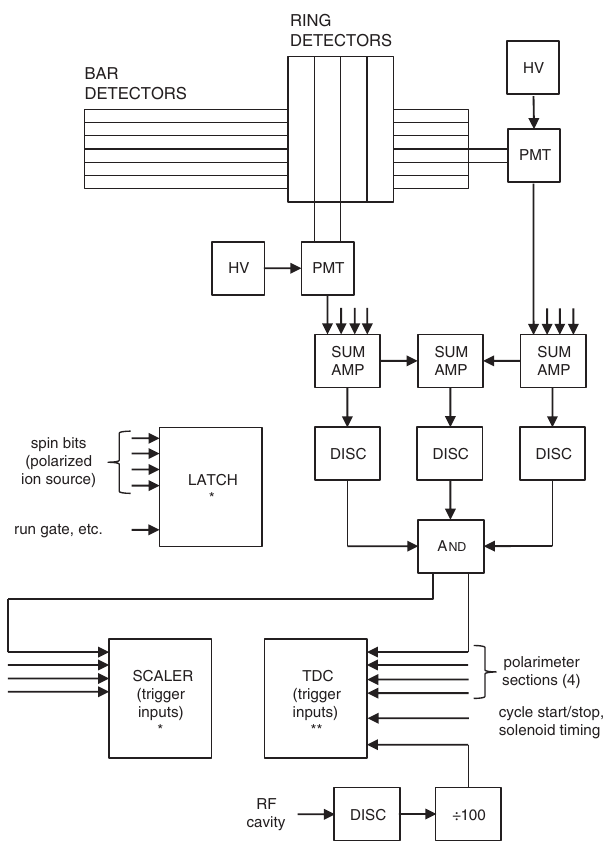
FIG. 2. Block diagram of the electronics for recording infor- mation from the EDDA detectors and other experimental param- eters. Only one photomultiplier tube (PMT) is shown for the bar and ring detectors. Other PMT analog signals are summed (SUM AMP) and sent to single channel analyzers (DISC) to produce logic outputs that mark pulses above threshold. Only one of the four event streams is shown. The triggers are generated by the AND gate and recorded simultaneously in a scaler and in a time-to-digital converter (TDC). Other system inputs include a prescaled signal from the COSY rf cavity, bits to identify the polarized ion source state, and timing information associated with the machine cycle. The latch and scaler are read out periodically (400 times per second) through a CAMAC system (*) while the TDC continuously streams data through a VME crate